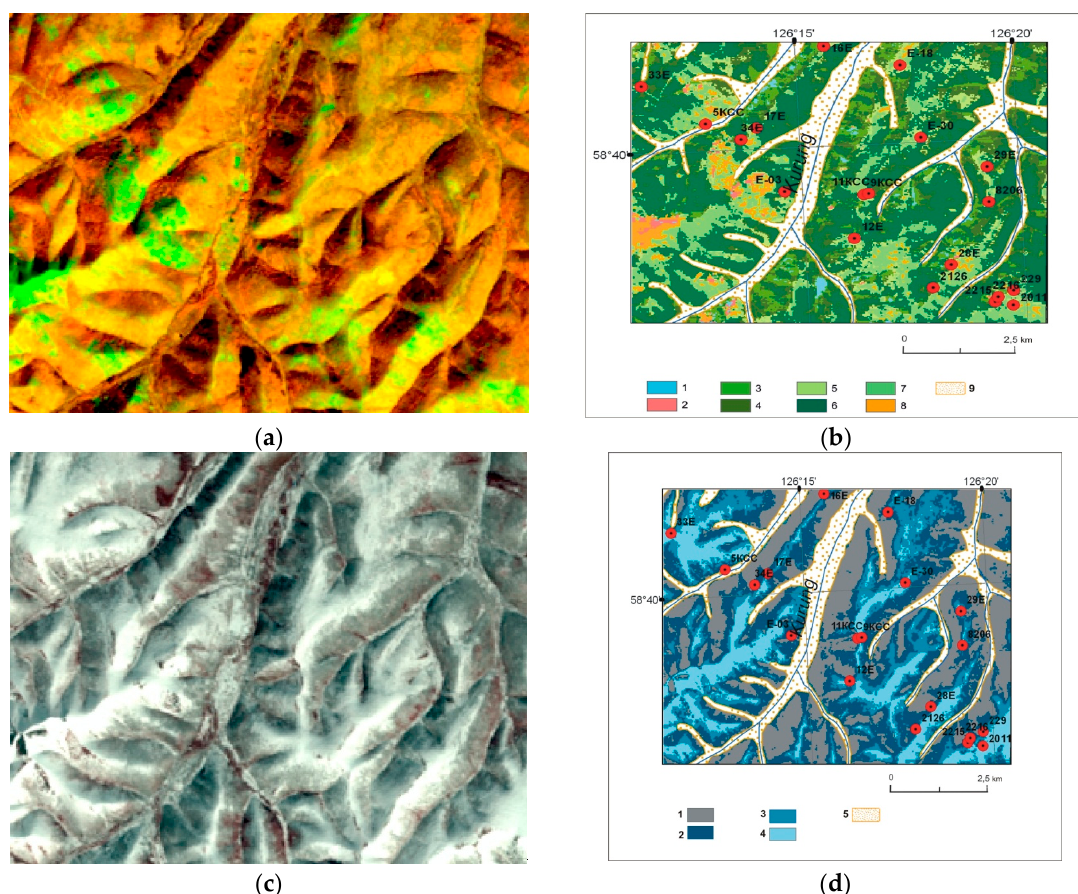
Figure 3. Processing of satellite images of Landsat ‐ 5/TM to interpret vegetation types and snow depth (on the example Elkon Massif). ( a ) Original multispectral image (band combination 4 ‐ 5 ‐ 3); ( b ) The resulting map of vegetation. Numbered dots—numbers of geothermal boreholes. 1—water bodies; 2—fires and deforestation; 3—larch forest; 4—sparse larch forest with mountain pine thickets; 5—open larch forest with alder, dwarf birch and mountain pine; 6—mountain pine thickets; 7—thinned mountain pine forest with rock debris; 8—stone fields (with lichen); 9—river valley. ( c ) Original multispectral image (band combination 4 ‐ 3 ‐ 2); ( d ) The resulting snow cover map. Numbered dots—numbers of geothermal boreholes. 1—Snow cover depth of 50–80 cm; 2—Snow cover depth of 80–100 cm; 3—Snow cover depth of 100–120 cm; 4—Snow depth 120 cm and more; 5—river valley.